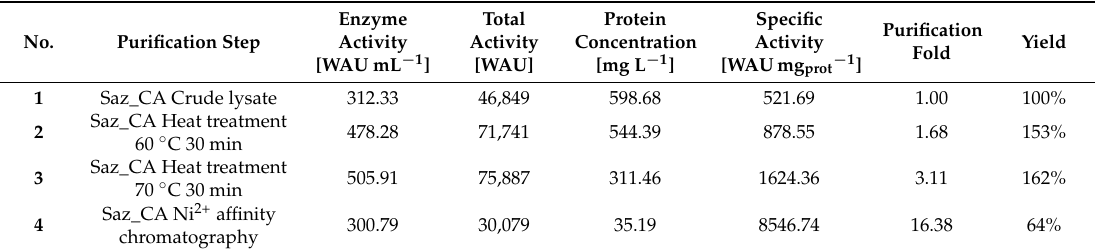
Table 1. Protein purification results of Saz_CA. WAU: Wilbur–Anderson unit.